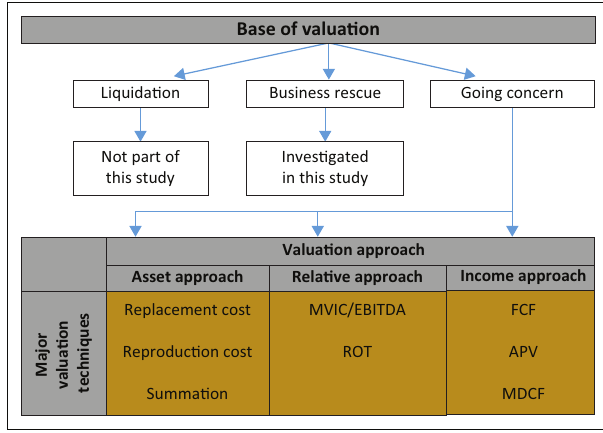
FIGURE 1: Valuation approaches and main valuation